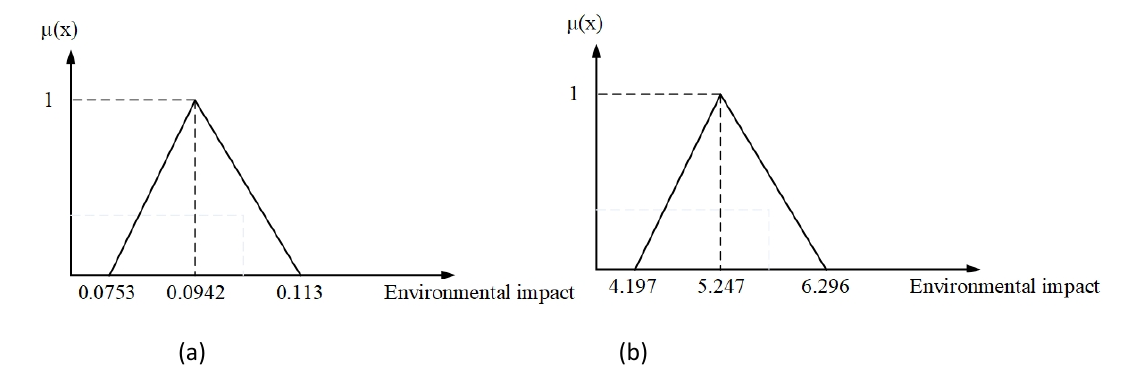
Fig. 7. Fuzzy membership functions of the environmental impact of (a) softwood lumber column and